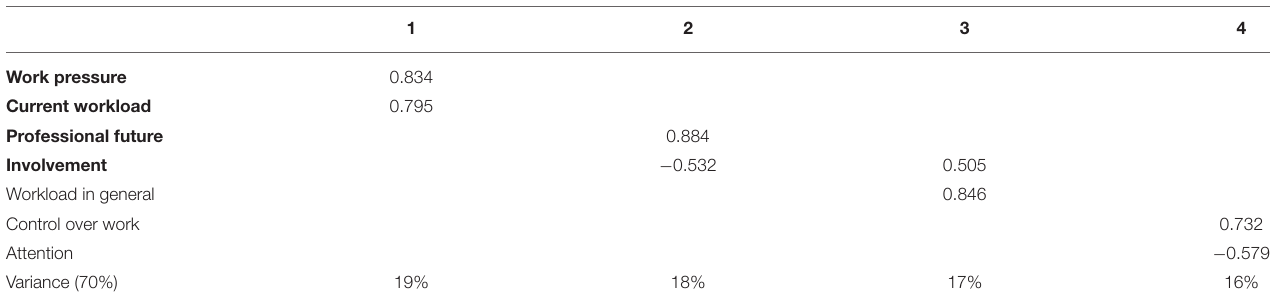
TABLE 3 | Results of the factorial analysis of psychosocial risk